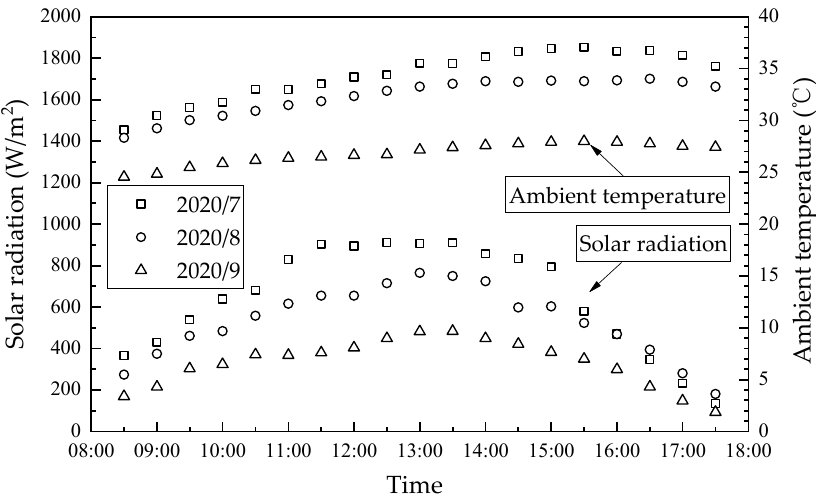
Figure 9. Hourly variation in average solar radiation and ambient temperature from July to September 2020 in Guilin, China.